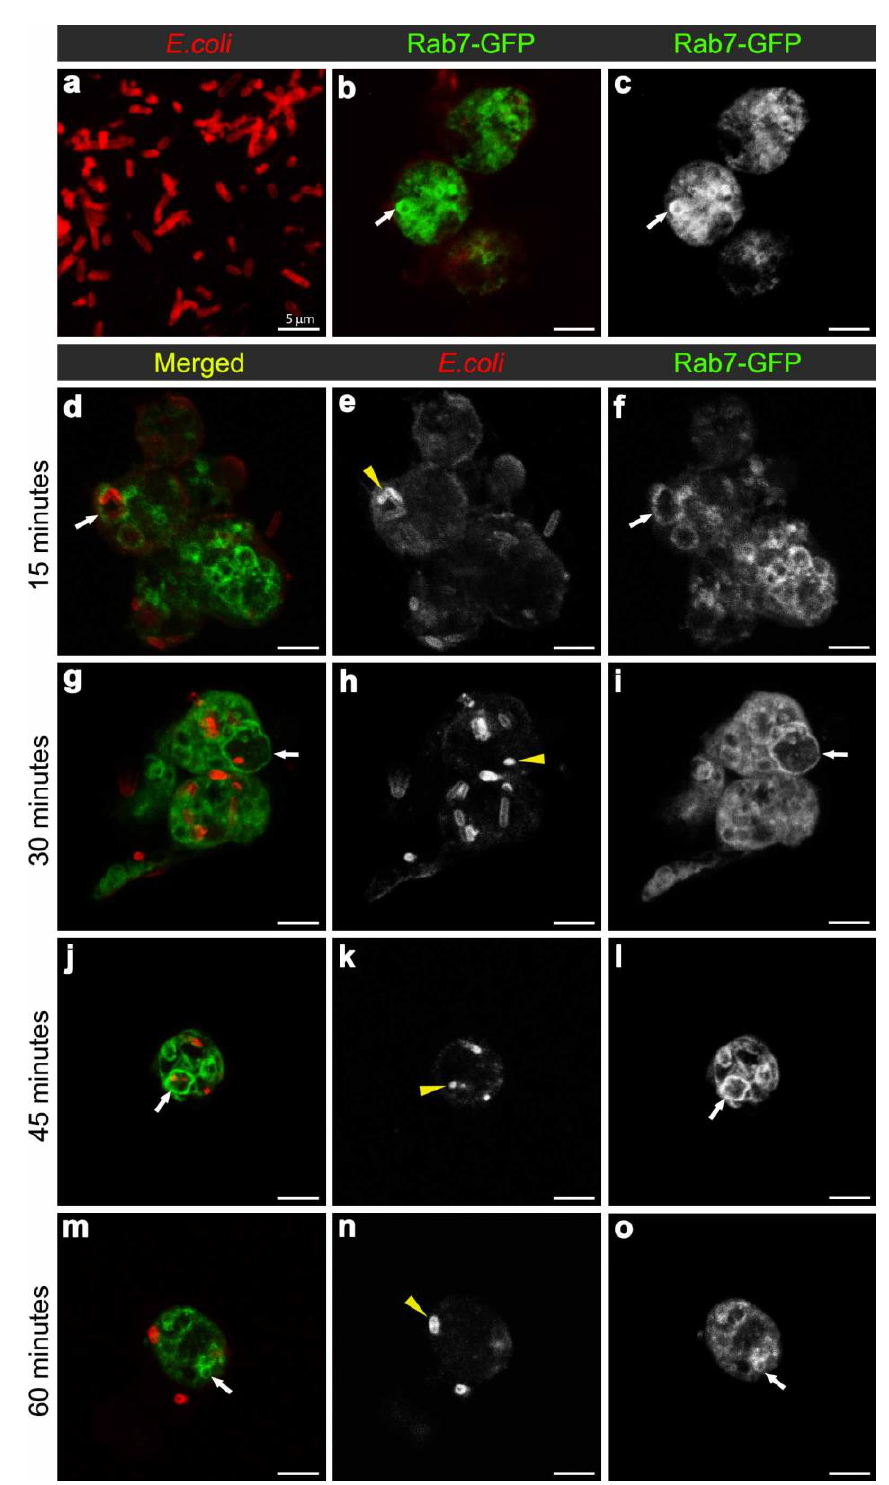
Figure 2. Confocal micrographs of intact E. coli (red in (a) , for scaling purposes to illustrate the size and rod-shape of free E. coli ), and Rab7-GFP positive vesicles (expressed using CG-GAL4>Rab7-GFP ): in uninfected hemocytes with vesicles in green (b) and grayscale (c) and depicted by arrows; and in hemocytes at 15 (d-f) , 30 (g-i) , 45 (j-l) , and 60 (m-o) minutes after infection with E. coli (red in d , g , j, m ; and grayscale in e , h , k, n, also depicted by yellow arrowheads). Rab7-GFP positive vesicles (green in d , g , j , m ; and grayscale in f , i , l, o ) are depicted with arrows. Scale bars = 5 µm as labeled in (a)